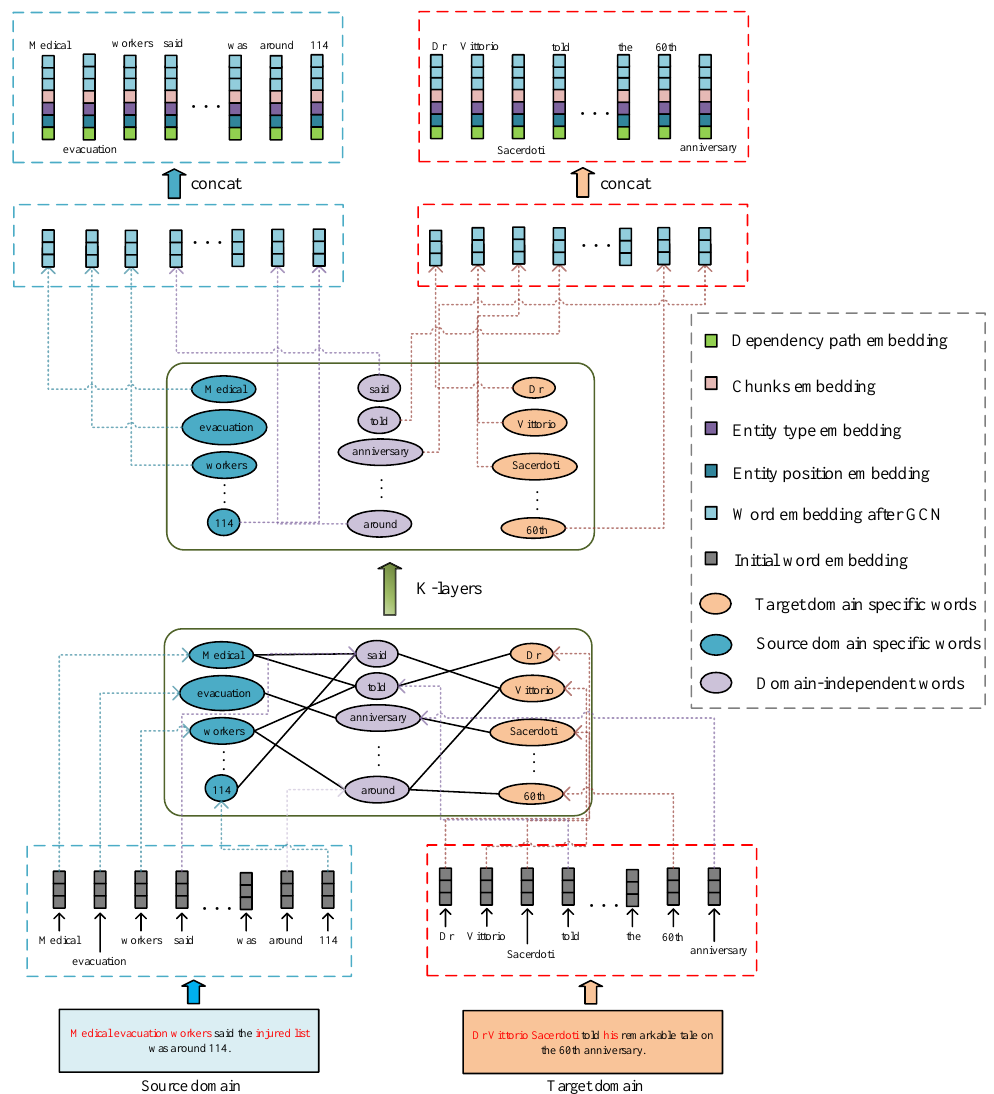
Figure 3. The architecture of GCN layer for aligning domain-specific